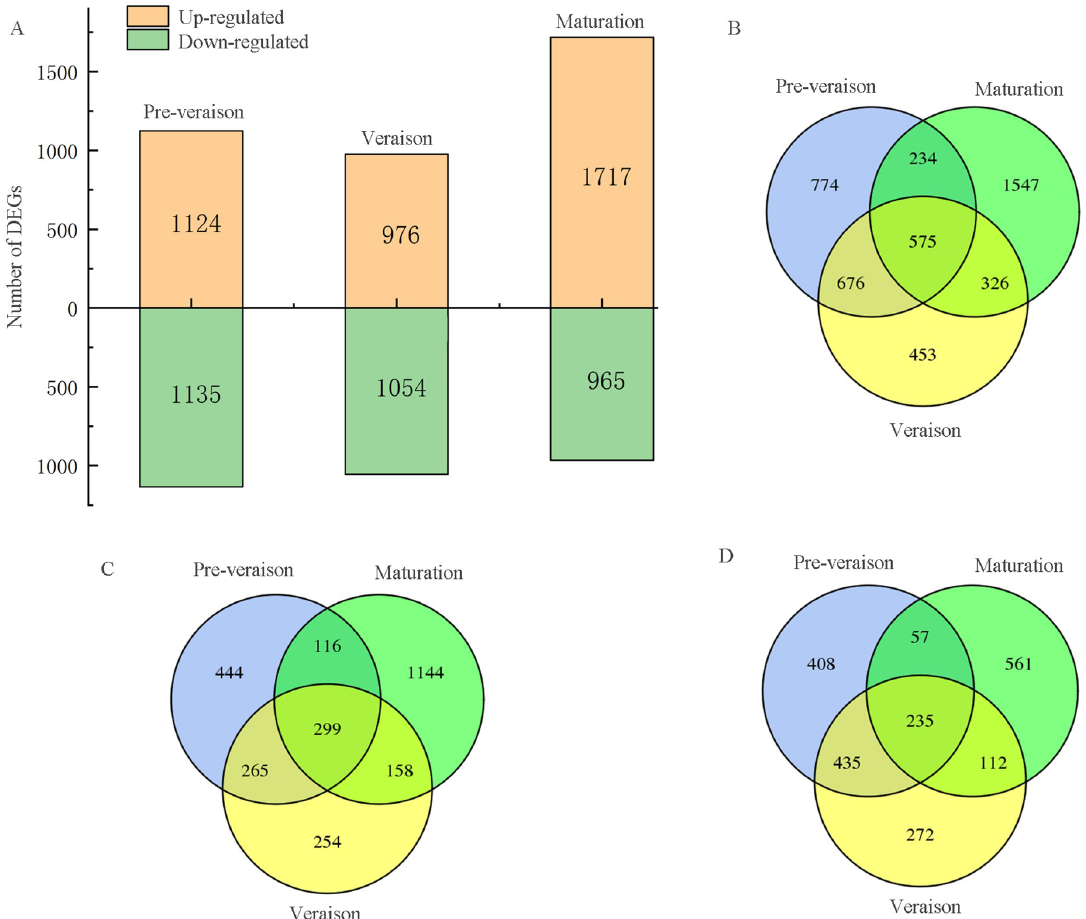
Fig 3. Analysis of DEGs between ‘Red Globe’ and ‘Muscat Hamburg’ at three developmental stages. (A) Number of up- and downregulated DEGs, using log2 fold change (|FC|) � 2. (B) Venn diagram of unique and common DEGs between ‘Red Globe’ and ‘Muscat Hamburg’ at the preveraison, veraison and maturation stages. (C) Venn diagram of upregulated DEGs between ‘Red Globe’ and ‘Muscat Hamburg’ at the preveraison, veraison and maturation stages. (D) Venn diagram of downregulated DEGs between ‘Red Globe’ and ‘Muscat Hamburg’ at the preveraison, veraison and maturation